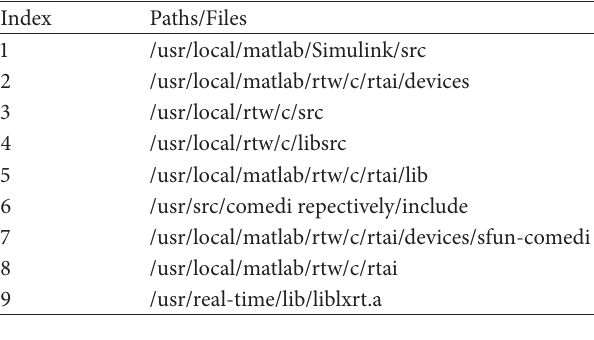
Table 2: Paths for the compiling process of RTAILab.